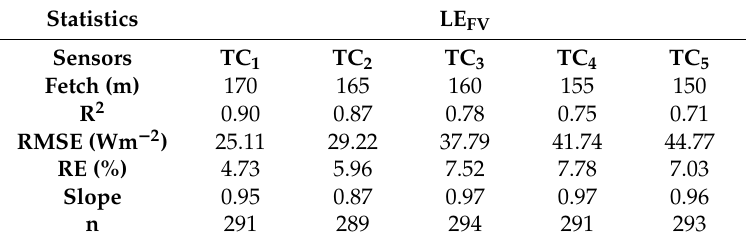
Table 5. Regression statistics of half-hourly LE FV vs LE EC as indicated by R 2 , RMSE, RE and the slope of linear